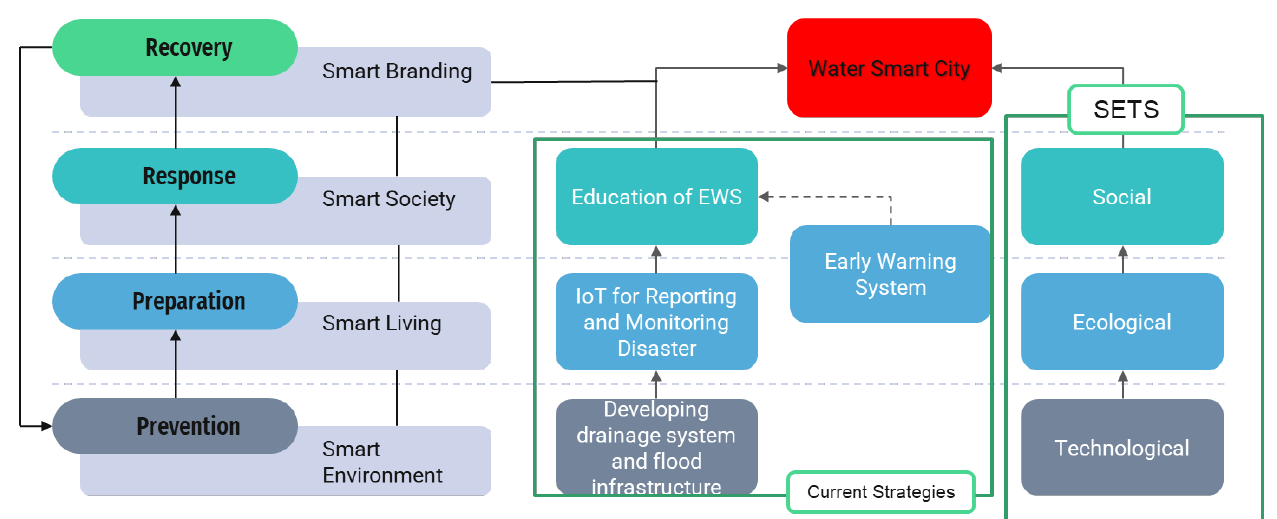
Figure 9. Water smart city approach in Balikpapan and Samarinda (Source: authors) .